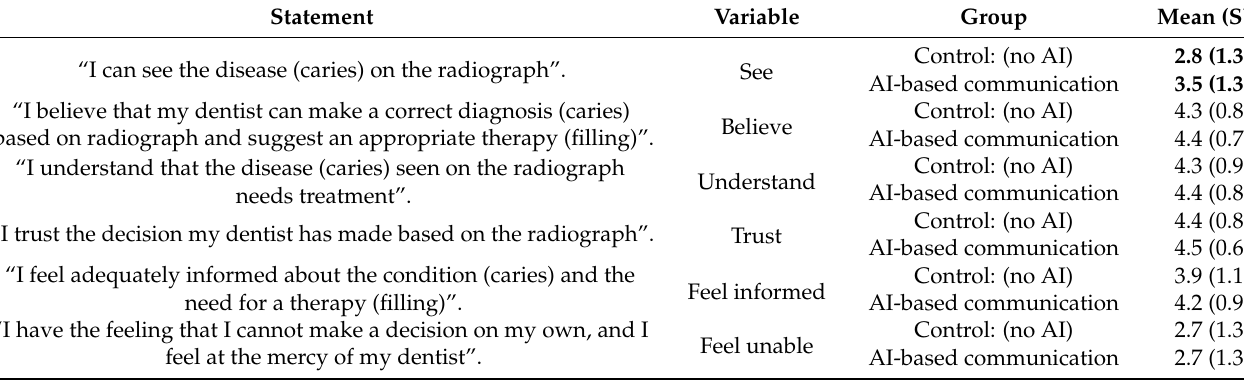
Table 1. Findings of the vignette-based controlled investigation. The mean (standard deviation) Likert-scale values (from 1—strongly disagree to 5—strongly agree) are shown. Bold values indicate statistically significant differences ( p < 0.05/Wilcoxon).